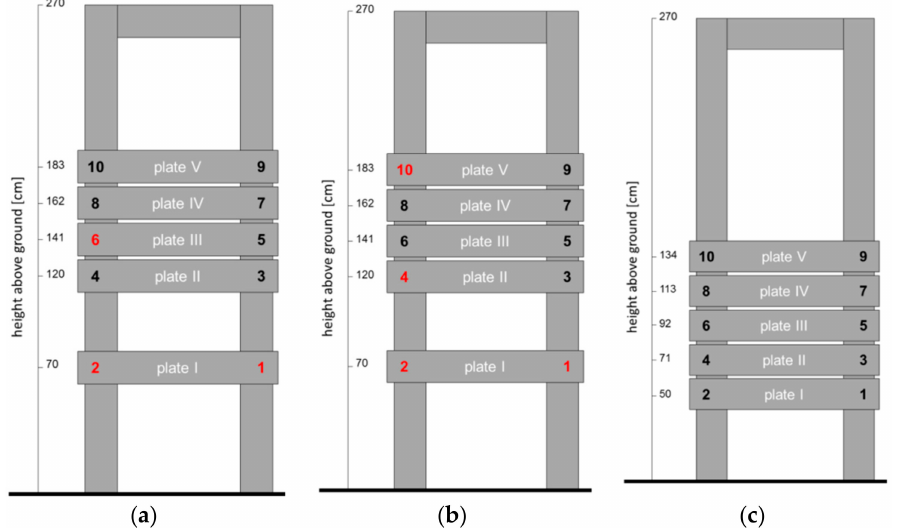
Figure 1. Configuration of the obstacle for the five selected avalanches: ( a ) 10 December 2010, ( b ) 5 March 2011, ( c ) 17 April 2013, 20 January 2014, and 30 April 2014. The red numbers indicate not-working load